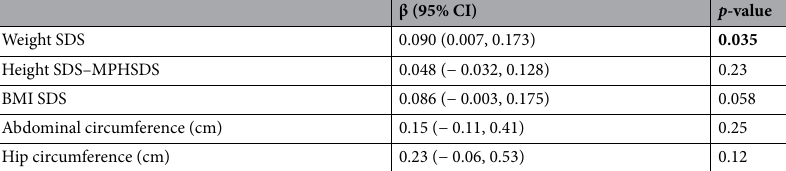
Table 3. Anthropometry at the 1-year follow-up in the offspring (n = 57) in association with maternal body mass index (BMI) in mid-gestation. Data are β coefficients and 95% confidence intervals (CI) derived from general linear models, including maternal gestational weight gain, adjusted for child’s sex, age, and trial group allocation. p -values for statistically significant associations (at p < 0.05) are shown in bold. MPHSDS, mid- parental height standard deviation score; SDS, standard deviation score.